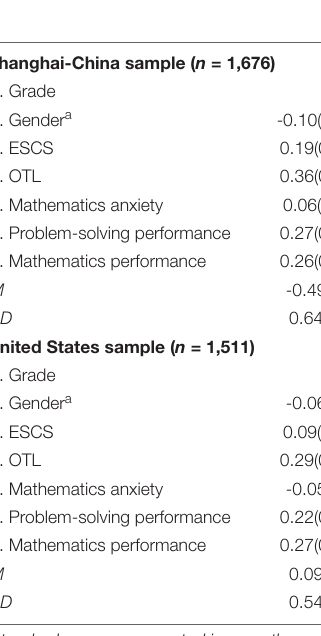
TABLE 1 | Means ( M ), standard deviations ( SD ), and correlations among variables.